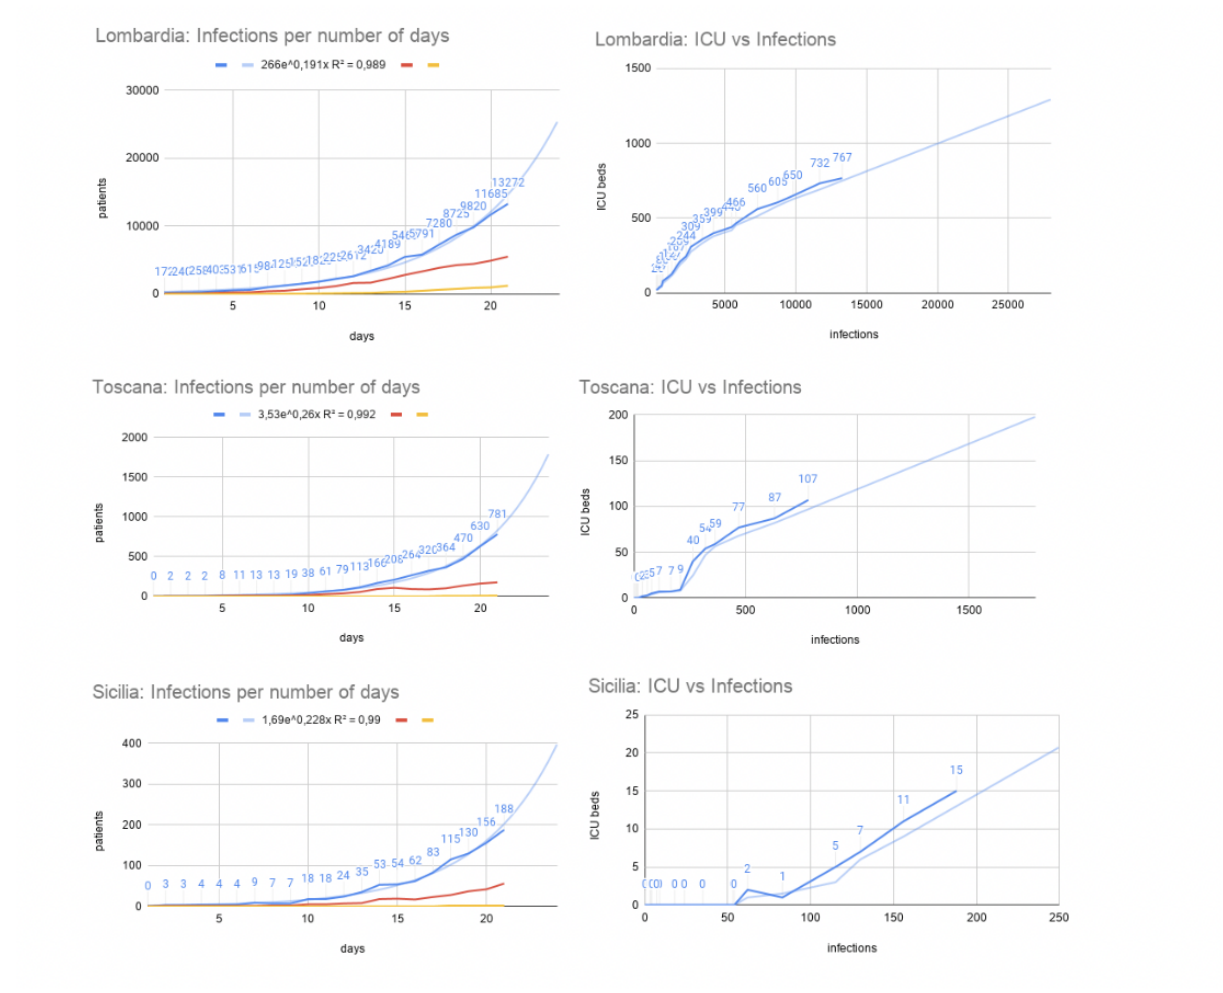
Figure 6. The figure depicts Lombardia, Toscana, and Sicilia regions as representative of infection situations in the northern, central, and southern regions of Italy, respectively, in a time window between days (0 days to 21 days; ie, February 24 to March 15, 2020) of infection in the official data set (ie, 3 weeks). In the left column, we report the number of infections per day, while in the right column, we have the occupied ICU beds as a function of the number of COVID-19 infections. In light blue, we report the fitting functions for the considered data (left column: exponential function; right column: weighted average with a modulus of 3). The red lines in the left column show the hospitalized patients with symptoms, and the yellow lines show the number of deaths. ICU: intensive care